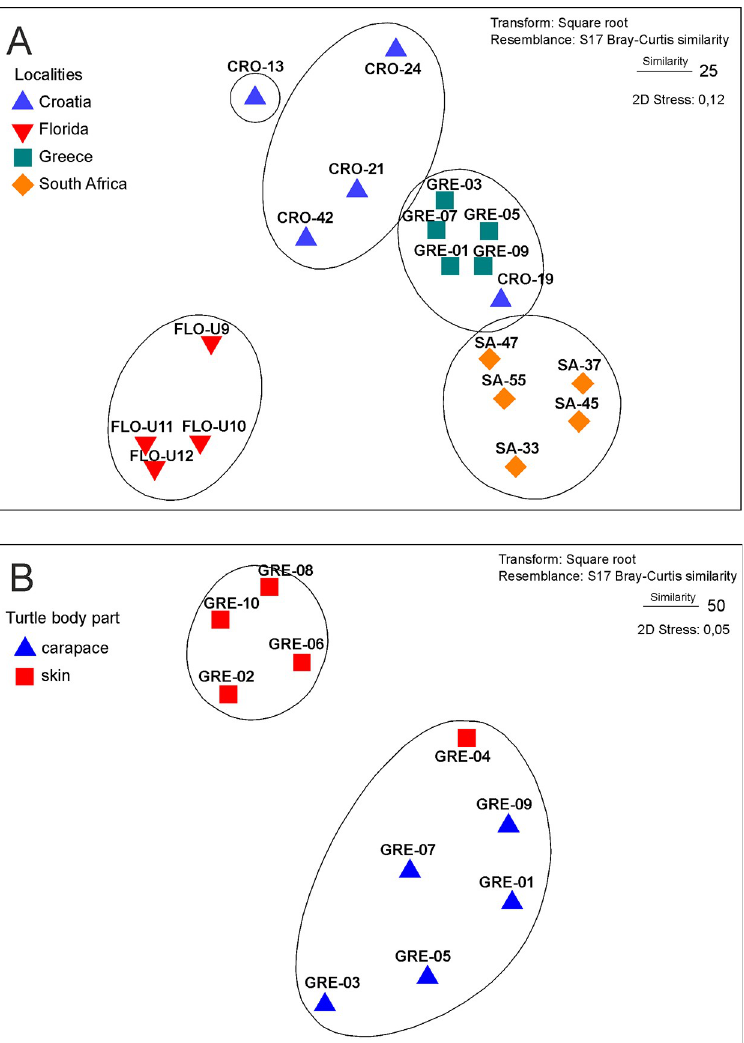
Fig 5. Non-metric Multi-Dimensional Scaling (nMDS) plots of diatom assemblages on loggerhead turtles. (A) Carapace samples from four localities. (B) Skin and carapace samples from Greece. The overlayed cluster analysis indicates grouping based on sample similarity of 25 and 50 in (A) and (B), respectively. CRO = Croatia, Adriatic Sea; FLO = Florida Bay, USA; GRE = Greece, Amvrakikos Gulf; SA = South Africa, Kosi Bay.